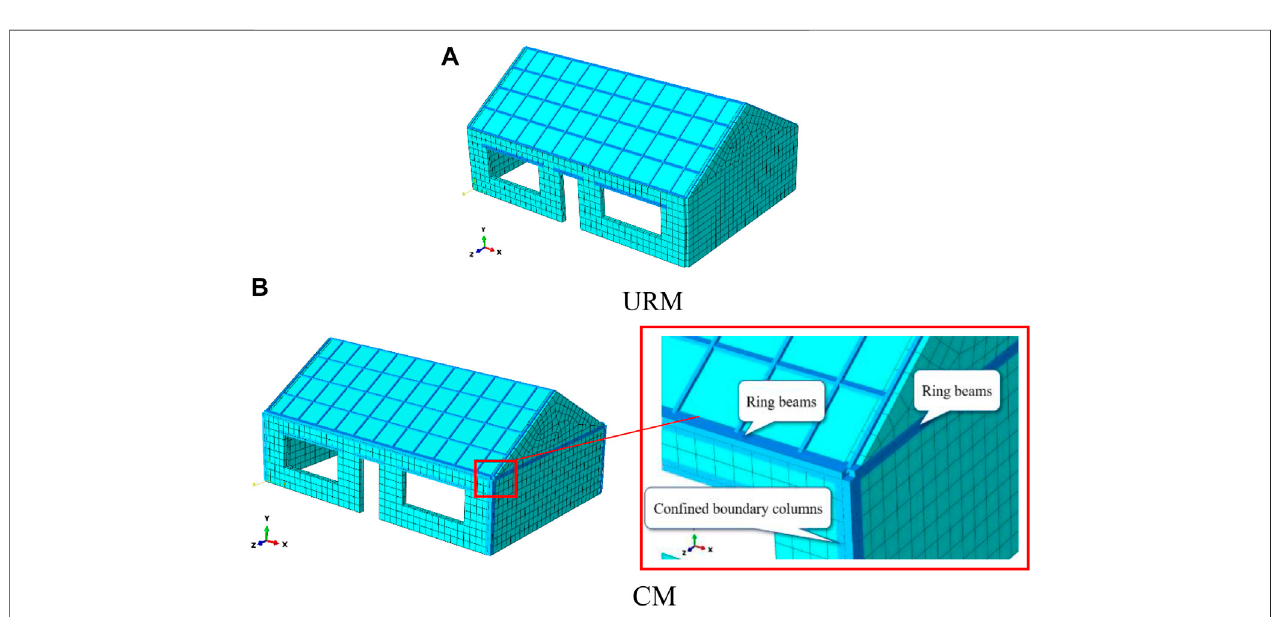
FIGURE 2 | Finite element models of single-story masonry structures. (A) URM. (B) CM.